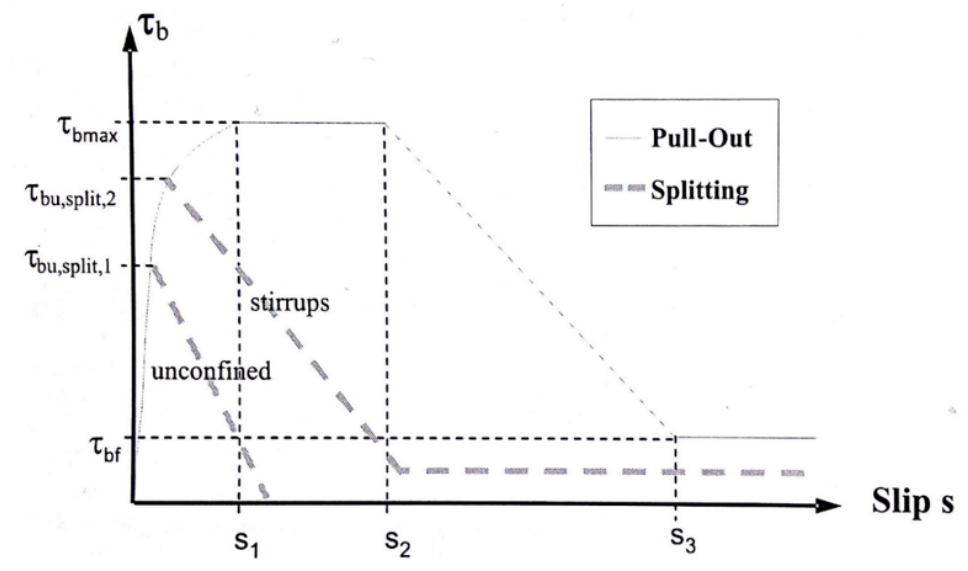
Figure 5. Bond stress–slip curve based on Model Code 1990 [16].